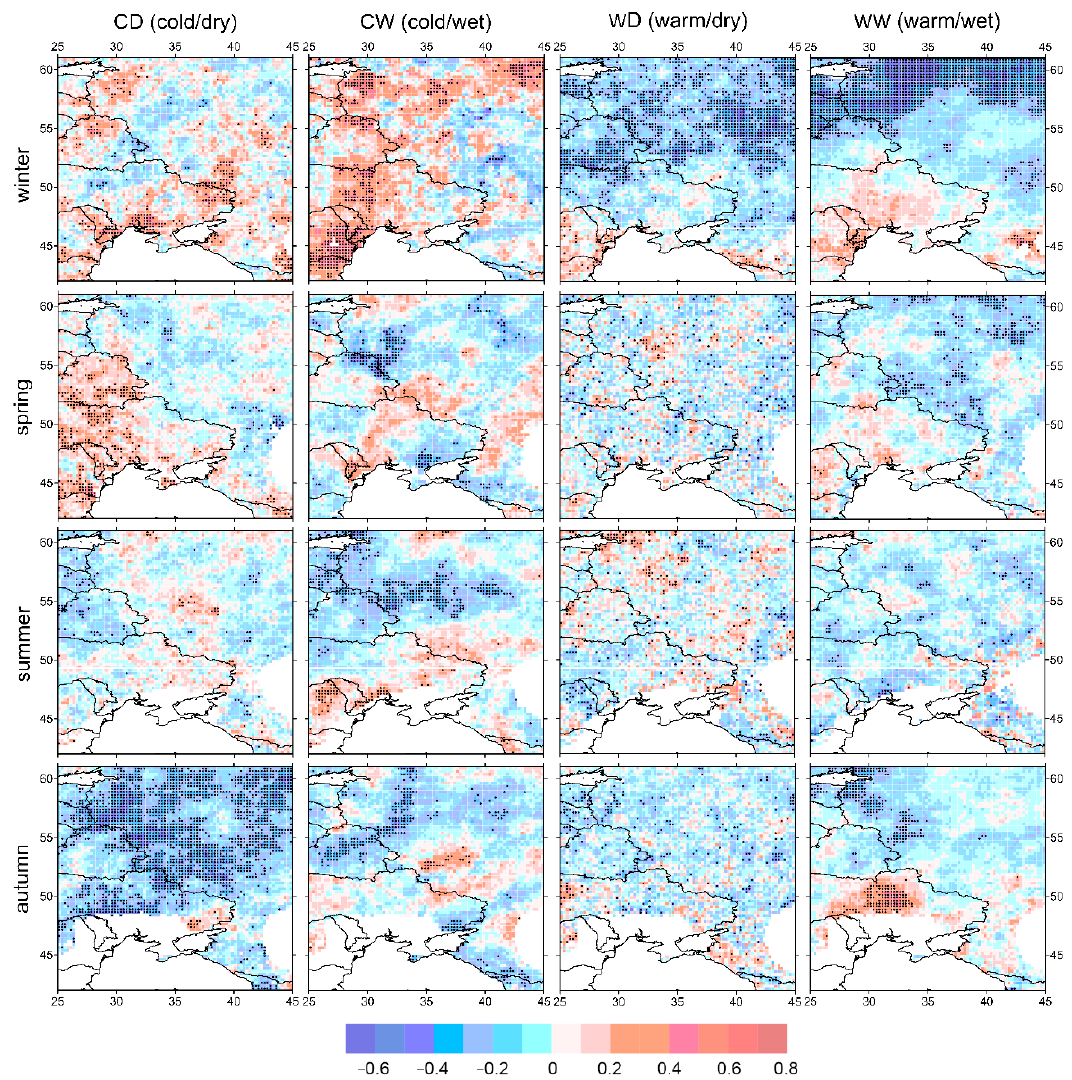
Figure 7. The spatial distribution of correlation coefficients for compound extreme indices and the S С AND. Statistically significant correlation coefficients ( p < 0.05) are shown as black dots.